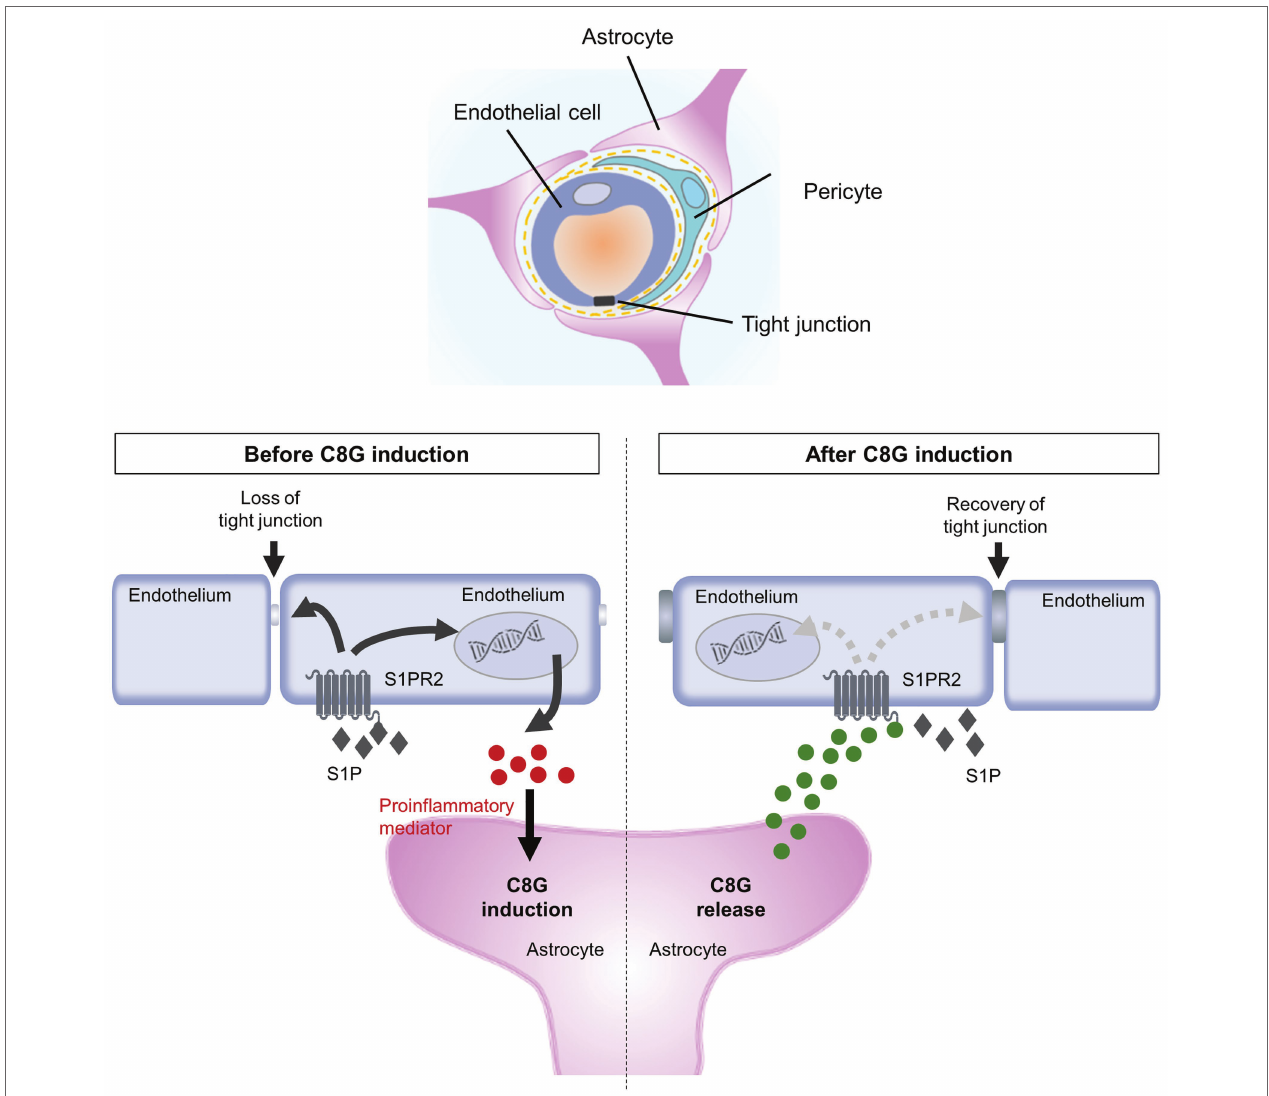
FIGURE 5 | Schematic diagram summarizing our findings. Inflammatory stimuli activate SPHK-1, thus facilitating S1P release (Xia et al., 1998; Tauseef et al., 2008; Fukuhara et al., 2012) and upregulating proinflammatory mediators in ECs. Endothelial S1PR2 expression is upregulated and activated by extracellular S1P, which induces the expression of proinflammatory and procoagulant molecules and reduces endothelial integrity (Zhang et al., 2013). Moreover, proinflammatory mediators, such as IL-1 β and IL-6, promote C8G induction in perivascular astrocytes. The C8G released from astrocytes interacts with endothelial S1PR2, resulting in blockage of inflammatory activation and BBB dysfunction. The intercommunication between astrocytes and ECs plays a crucial role in the modulation of the integrity of the